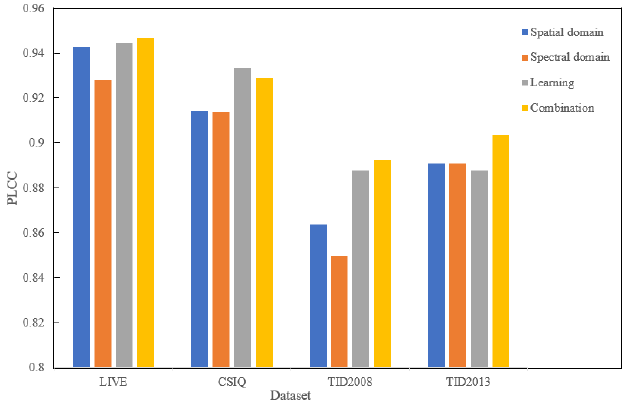
Figure 9. PLCC value of different groups of methods on analog distortion datasets.